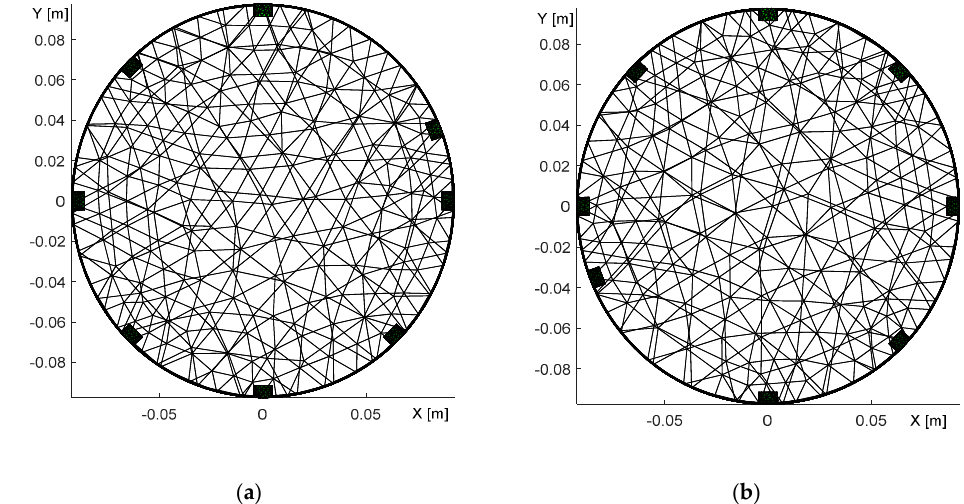
Figure 14. A top view of the optimized domain, with the electrode misplacement obtained through oppositesensing. The images display the shifted ( a ) 2nd electrode; ( b ) 6th electrode.